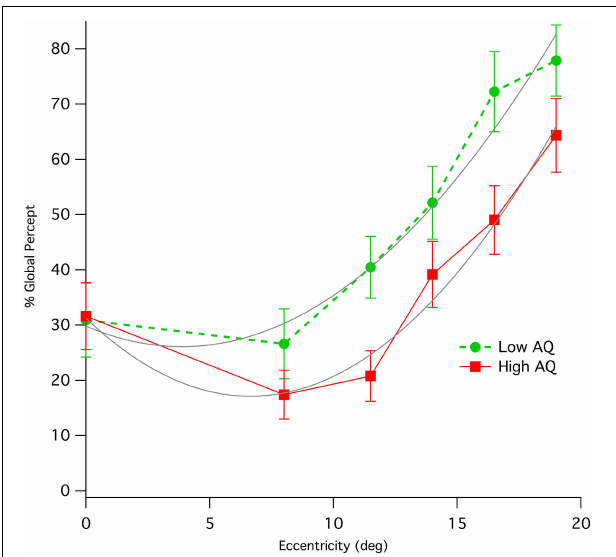
FIGURE 3 | Means (with standard error) of percentage of initial global percept for Low and High AQ groups when viewing the stimulus at various eccentricities in visual field. The data for High AQ are shown with a solid red line, while those for the Low AQ group are shown as a dashed green line. Parabolic fits (gray color) to the two sets of data allow a comparison of relative eccentricities required to give equivalence of global percept between the High AQ and Low AQ